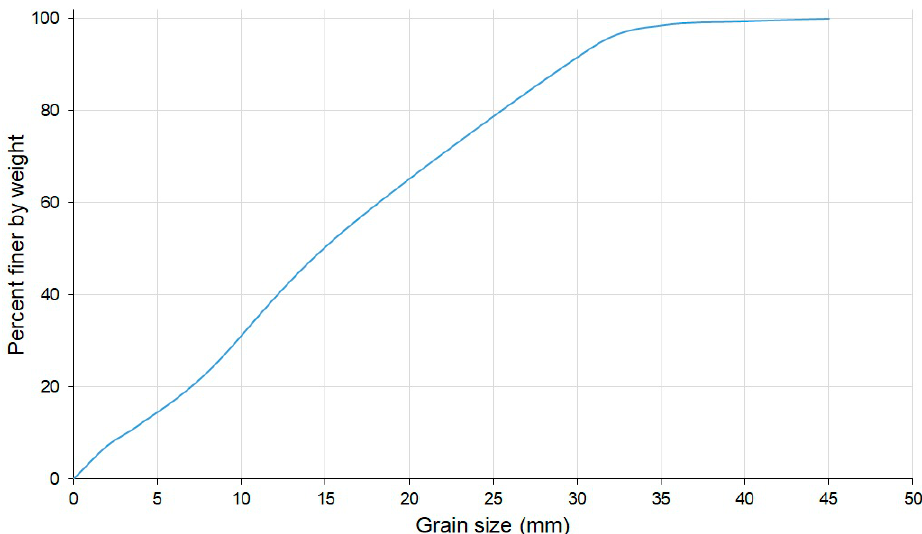
Figure 6. Particle size distribution of the artificial aggregate obtained after crushing the material in a jaw crusher. Table 3. Main properties of the artificial aggregate obtained from asbestos-containing material (ACM).